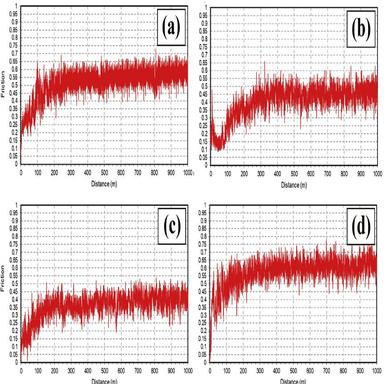
Variations of friction coefficient versus the sliding distance for (a) FSP modified AA6061 aluminum alloy and (b-d) processed AA6061-Graphene-TiB2 hybrid nanocomposites with 20 wt% of TiB2 particles and different contents of graphene as; (b) 0.5 wt%, (c) 1 wt%, and (d) 2 wt%.